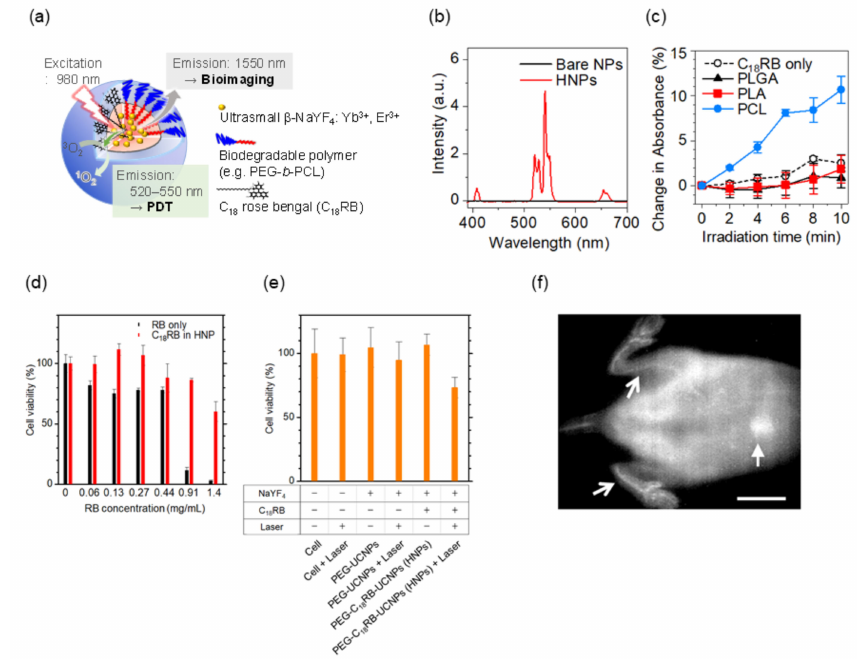
Figure 5. Upconversion luminescent nanostructure for NIR-induced photodynamic therapy. ( a ) Design of hybrid nanoprobes (HNPs) composed of hydrocarbonized photosensitizer (C 18 rose ben- gal dye, RB) and upconversion ultrasmall NaYF 4 :Er 3+ ,Yb 3+ nanoparticles (NPs). At the hydrophobic core of biocompatible PEG-b-PCL copolymers, the dyes are coupled with a cluster of the upconversion nanoparticles. Under 980 nm irradiation, the nanoparticles emit upconversion visible luminescence (520–550 nm) that activates C 18 RB dyes to generate singlet oxygen for photodynamic therapy and 1550 nm NIR luminescence for in vivo bioimaging. ( b ) Upconversion luminescence spectra of the HNPs dispersed in water. Bare NaYF 4 :Er 3+ ,Yb 3+ NPs were used as a control. ( c ) Generation of singlet oxygen by HNPs (1 mg/mL) in water under 980 nm light irradiation (0.8 W/cm 2 ). ( d ) Cytotoxicity of free RB and C 18 RB-loaded HNPs on cultured Colon-26 cells without 980 nm optical excitation. The toxicity of the RB compounds was reduced by the encapsulation. ( e ) NIR-induced photodynamic therapy effect of HNPs on Colon-26 cells. ( f ) NIR fluorescence in vivo imaging with the HNPs in mice (wavelength: 1550 nm; Scale bar: 10 mm). Arrows and a block arrow indicate hindlimb blood vessels and liver, respectively. Adapted from reference [87] with permission with the terms of the Creative Commons CC BY